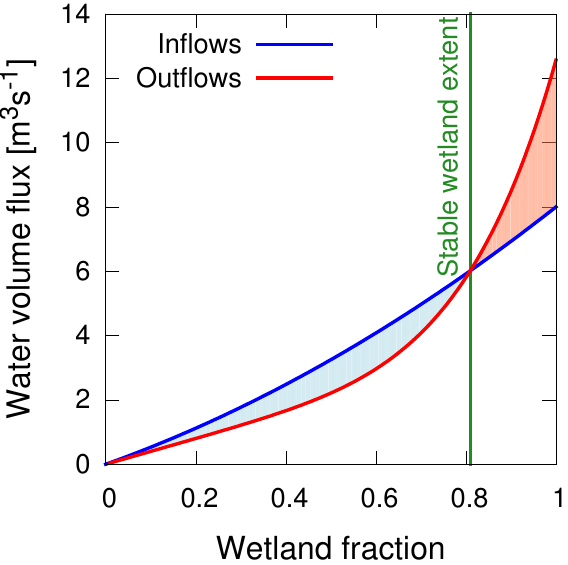
Fig. 2. Maximum sub-grid slopes that occurs for a given grid cell fraction. The grey area displays discrete slope data derived from the GTOPO30 dataset for an example MPI-HM grid cell. The red line displays an analytical approximation of these data based on Eq.